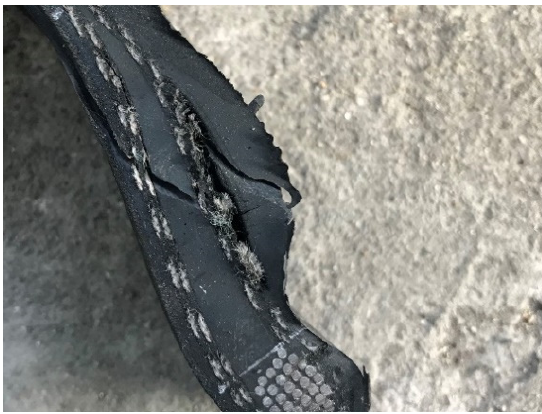
Figure 15. Failure section of tested tire. Table 4. Fatigue life of the 175/75R14 tire bead.